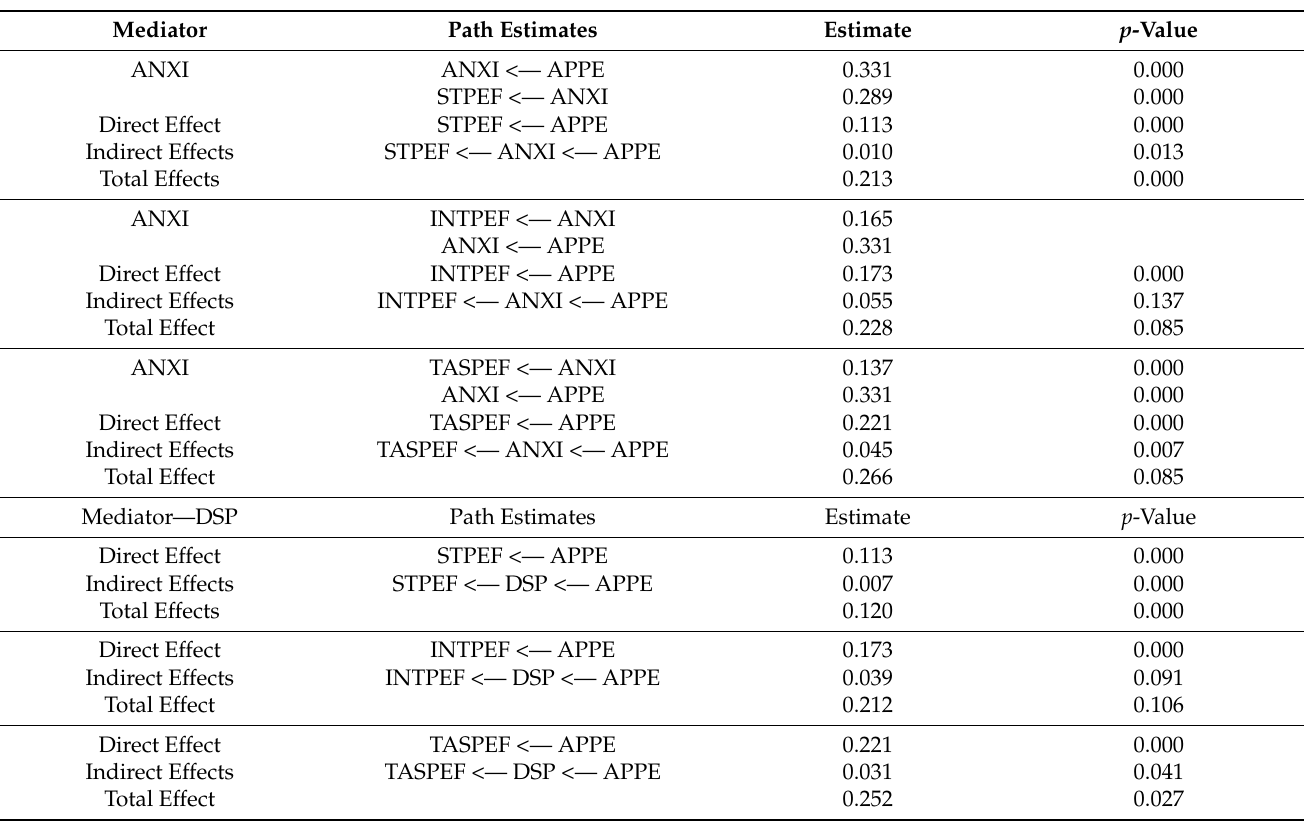
Table 7. Mediation